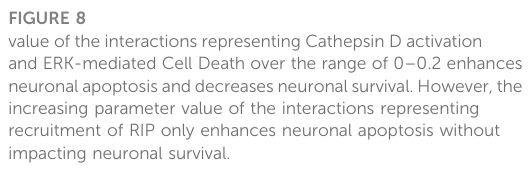
FIGURE 8 value of the interactions representing Cathepsin D activation and ERK-mediated Cell Death over the range of 0 – 0.2 enhances neuronal apoptosis and decreases neuronal survival. However, the increasing parameter value of the interactions representing recruitment of RIP only enhances neuronal apoptosis without impacting neuronal